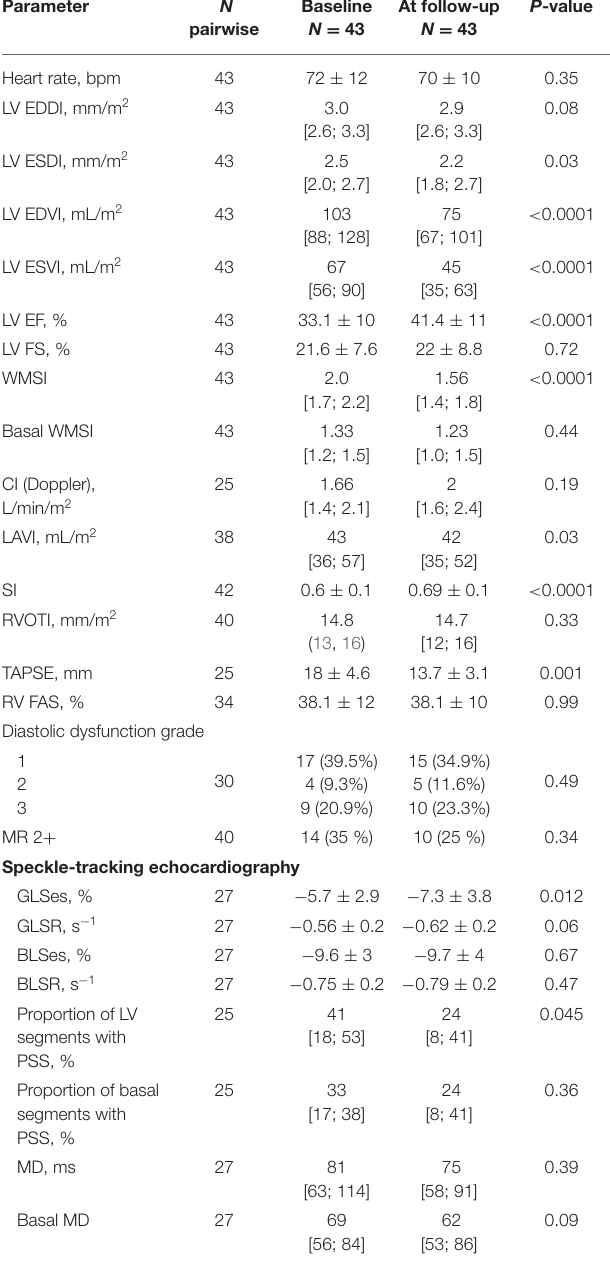
TABLE 2 | Echocardiographic parameters at the short-term follow-up after SVR.